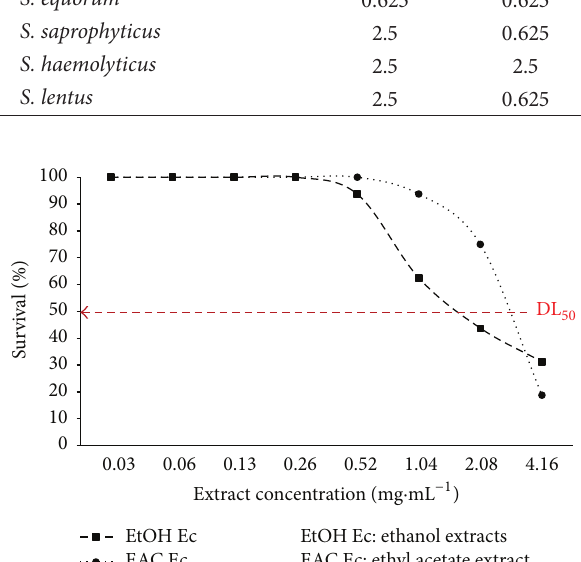
Figure 5: Variation of A. salina larval mortality according to C. nitida extracts